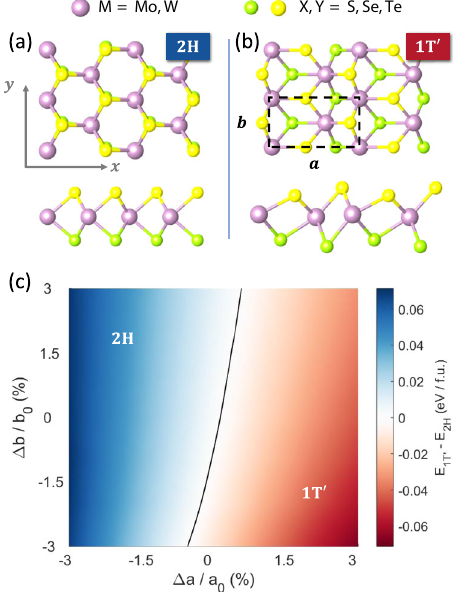
Fig. 2 2H and 1T ′ phases of JTMDs. a , b Atomic structure of 2H and 1T ′ phase of JTMD. The black box in b shows the unit cell of 1T ′ phase. The top and bottom chalcogens are shifted a bit for better visibility. c The 2H-1T ′ phase diagram of WSeTe. a 0 and b 0 are the fully relaxed lattice constants of the 1T ′ phase. The color map indicates the energy difference between 1T ′ and 2H phases. 1T ′ and 2H phases are energetically favored in red and blue regions,